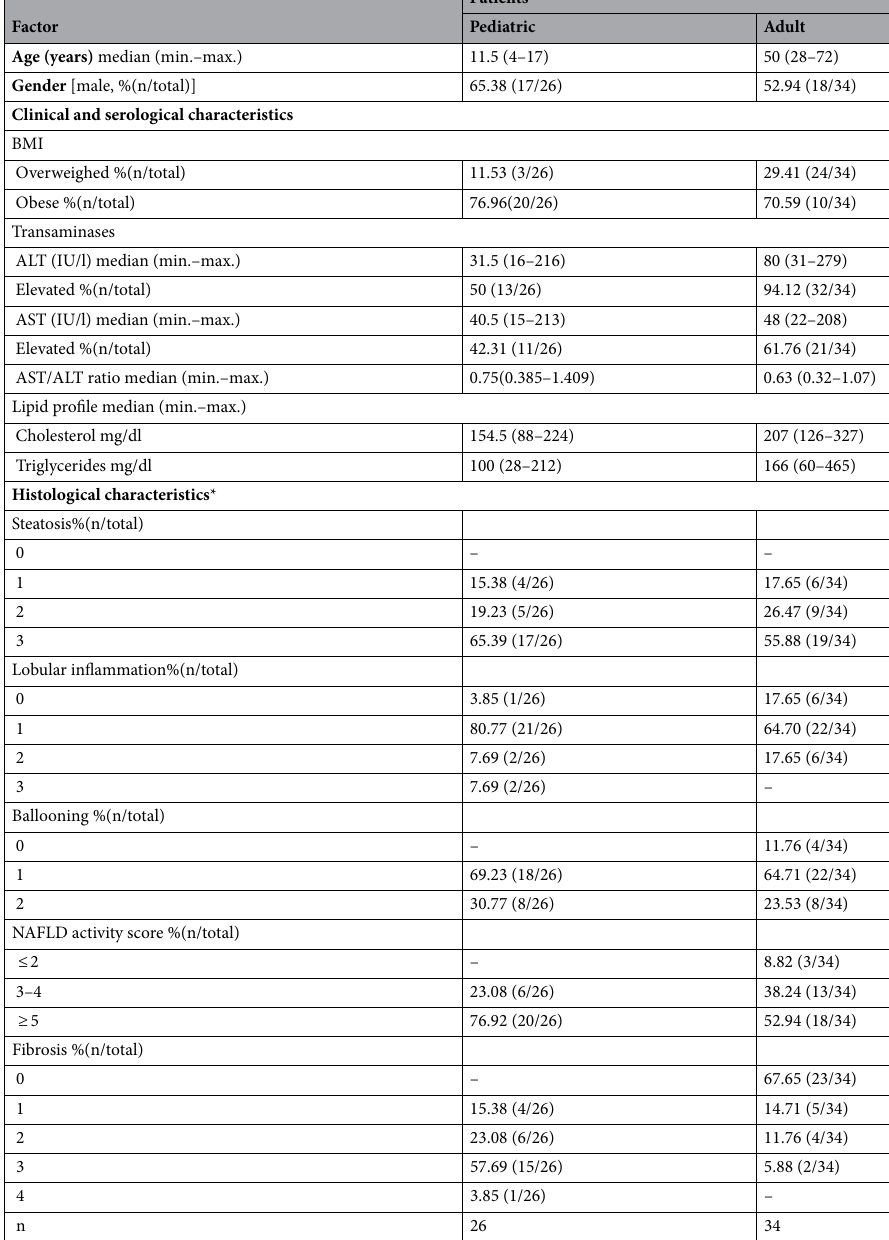
Table 1. Clinical and histological patients feature. BMI : Body Mass Index (kg/m 2 ), in pediatric patients the values defined by the Argentine Society of Pediatrics were used to determine overweight and obesity (https :// www.sap.org.ar/uploa ds/conse nsos/obesi dad-gu-iacut eas-para-su-abord aje-cl-iacut enico -2015.pdf). In the case of adult patients: normal weight (< 25.0 kg/m 2 ), overweight (25.0–29.9 kg/m 2 ) and obesity (≥ 30 kg/m 2 ). ALT alanine aminotransferase; AST aspartate aminotransferase. Normal ALT and AST levels for pediatric patients were ≤ 32 and ≤ 48 IU/L, respectively when testing was done at 37 °C. Normal ALT and AST levels for adult patients were ≤ 40 and ≤ 42 IU/L, respectively when testing was done at 37 °C. The normal ranges for cholesterol and triglyceride were 120–219 mg/dl and 31–119 mg/dl, respectively. *Steatosis Grade: score 0 (< 5%cells), 1 (5–33%), 2 (33–66%) and 3 (> 66%); lobular inflammation: score 0 (0 foci), 1 (< 2 foci), 2 (2–4 foci) and 3 (> 4 foci); ballooning grade: score 0 (none), 1 (few ballooning cells) and 2 (many cells/prominent cells); fibrosis stage: score 1 (a, b = mild (1a)/ moderate (1b) zone 3 perisinusoidal fibrosis; 1c = only portal fibrosis); 2 (zone 3 and portal/ periportal fibrosis), 3 (bridging fibrosis) and 4